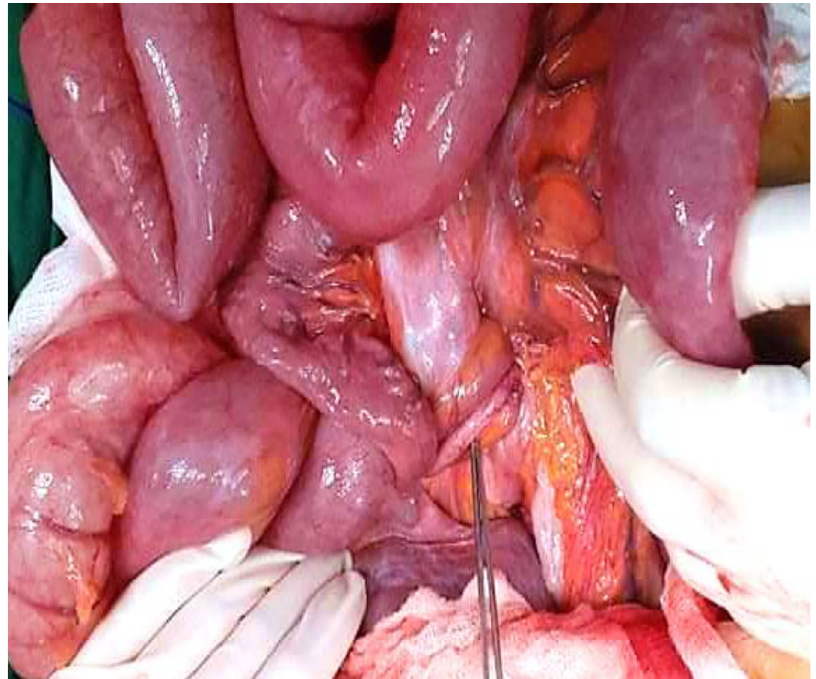
Figure 7. At the base of the volvulus, the inflammatory appendix wrapped around the last loop of the ileum.